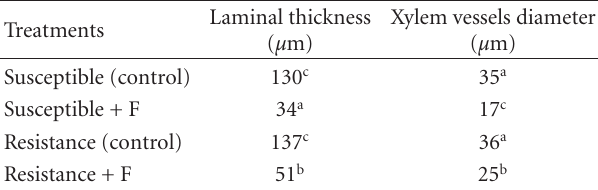
Table 4: Some anatomical parameters in the two sensitive and resistant biotypes of E. crus-galli, that is, laminal thickness and vessel diameters after 14 days of treatment with fenoxaprop-p-ethyl compared with untreated ones.